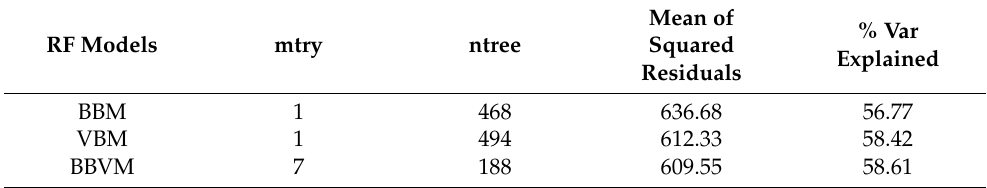
Table 5. The best mtry, ntree, and performance of the three models.